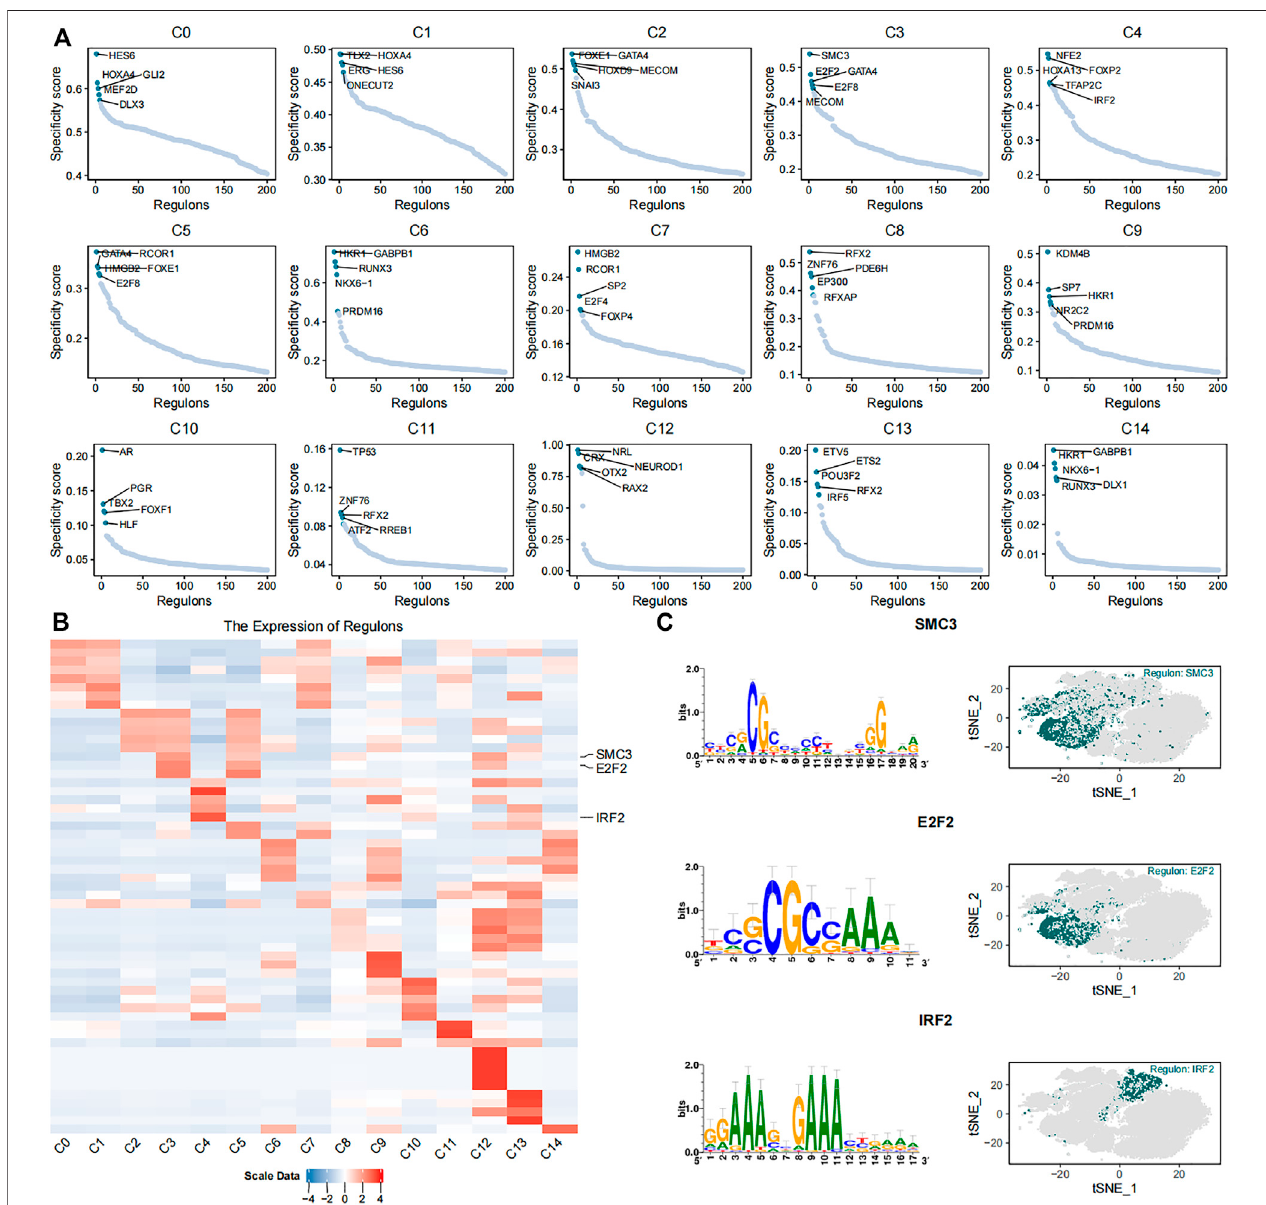
FIGURE 4 | Identi fi cation of key gene regulatory networks in the 15 cell subsets. (A) The scatter plots show expression of the top fi ve highly expressed regulons in eachofthe15cellsubsets. (B) Theheatmapplotshowsexpressionlevelsofthetop fi vehighlyexpressedregulonsinthe15differentcellsubsets. SMC3 , E2F2 ,and IRF2 regulons are labeled. (C) The plots show the putative binding motifs of SMC3 , E2F2 , and IRF2 , as well as their corresponding expression levels in different cells among the 15 cell subsets.